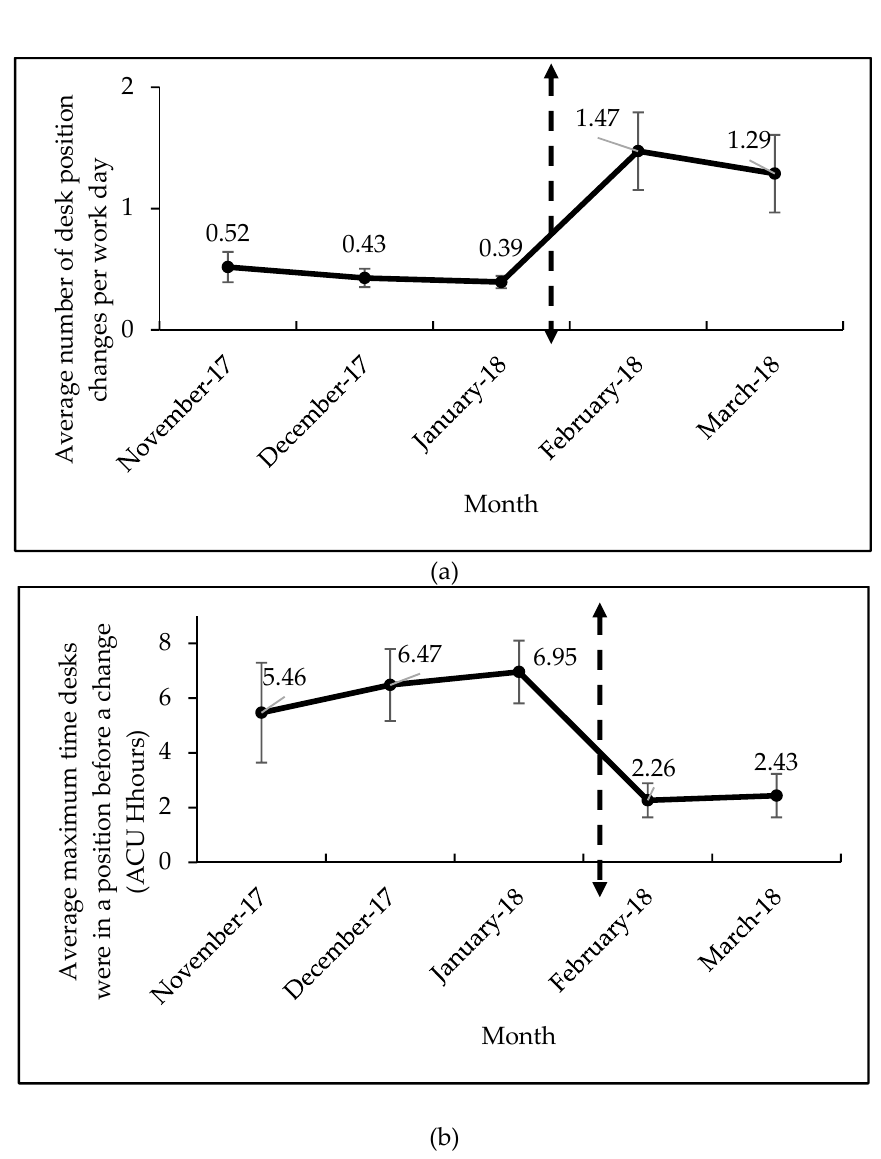
Figure 4. Overall group means of desk position changes and max time desk in a position during each month of the study. Desk position changes per work day ( a ) and average maximum time desks were in a position before a change in ACU hours ( b ) are shown. Dashed line with two arrows indicates the beginning of the intervention. 25 December 2017–5 January 2018 data were excluded from this analysis. Error bars represent 95% confidence intervals.